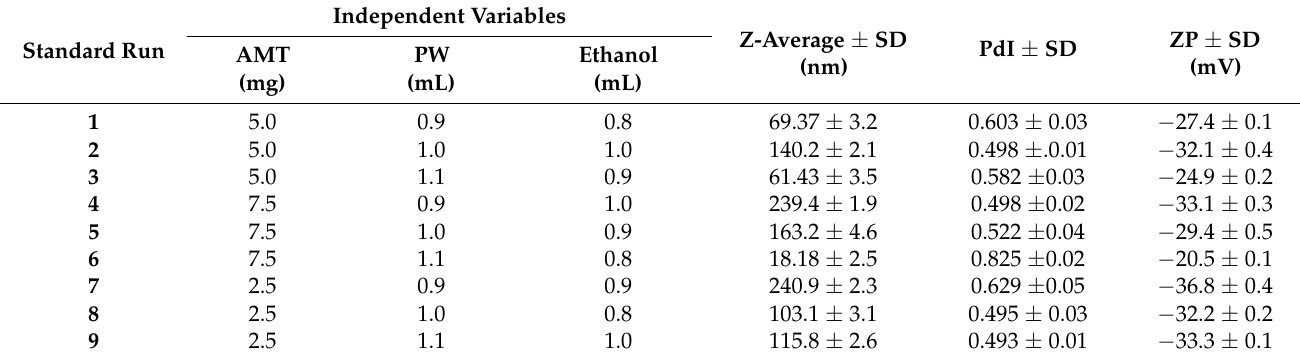
Table 1. Experimental design for the optimization and the responses. Data are presented as means ± SD ( n =